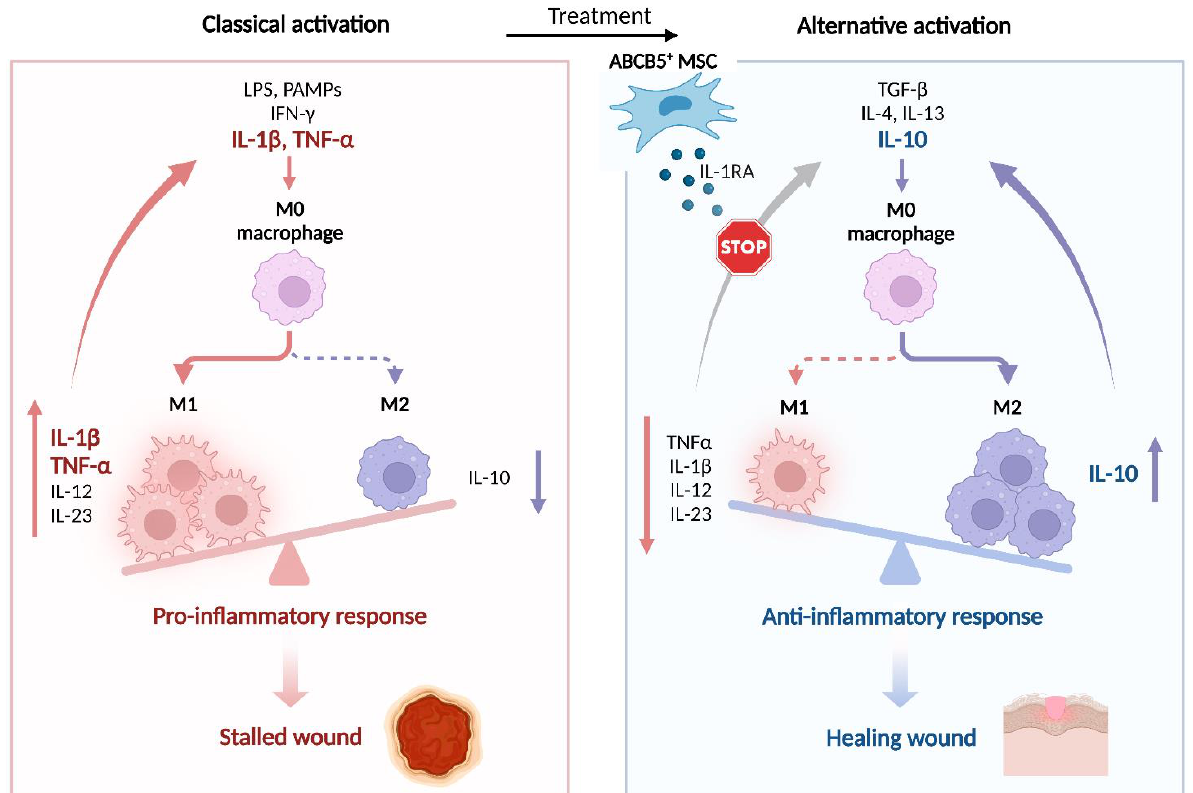
Figure 4. ABCB5 + MSCs trigger M1-to-M2 macrophage phenotype shift in chronic wounds. Chronic wounds are stalled in the inflammatory phase through IL-1 β - and TNF- α -mediated persistent autocrine recruitment and activation of pro-inflammatory M1 macrophages (left panel). Upon therapeutic application (right panel), ABCB5 + MSCs block IL- 1β signaling by adaptive release of IL -